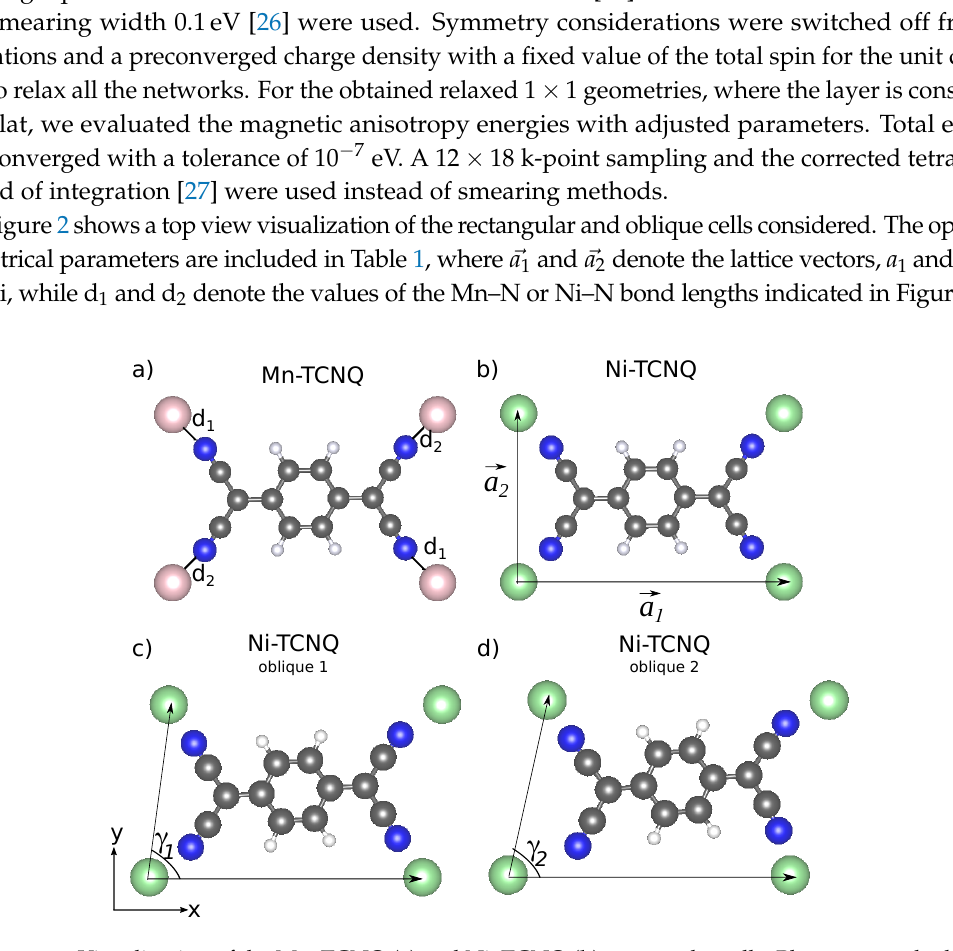
Figure 2. Visualization of the Mn–TCNQ ( a ) and Ni–TCNQ ( b ) rectangular cells. Blue, gray, and white circles correspond to N, C, and H atoms respectively, while bright violet and bright green circles correspond to Mn and Ni atoms. The fluorinated (F4)TCNQ molecules differ from regular TCNQ only in having F atoms instead of H, the corresponding C–F bond lengths being somewhat longer than those of C–H. Panels ( c , d ) show the distorted cell models used for Ni–TCNQ. Geometry details are found in Table 1. TCNQ,